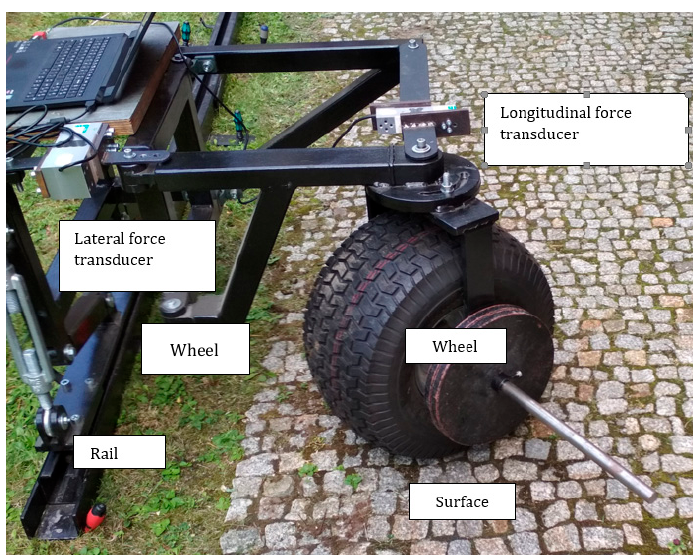
Figure 1. Experimental stand for the wheel–road interaction tests [21].